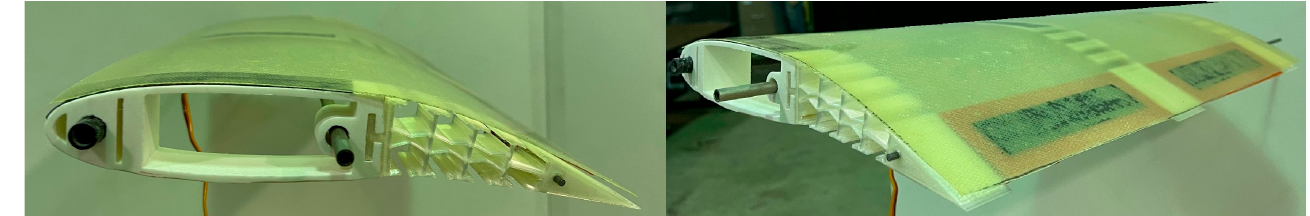
Figure 18. ( a ) assembled wing model; ( b ) cambered wing model.